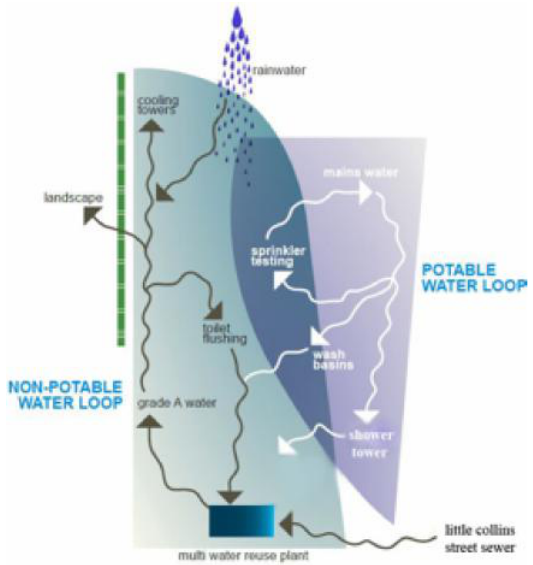
Fig. 7: water recycling in CH